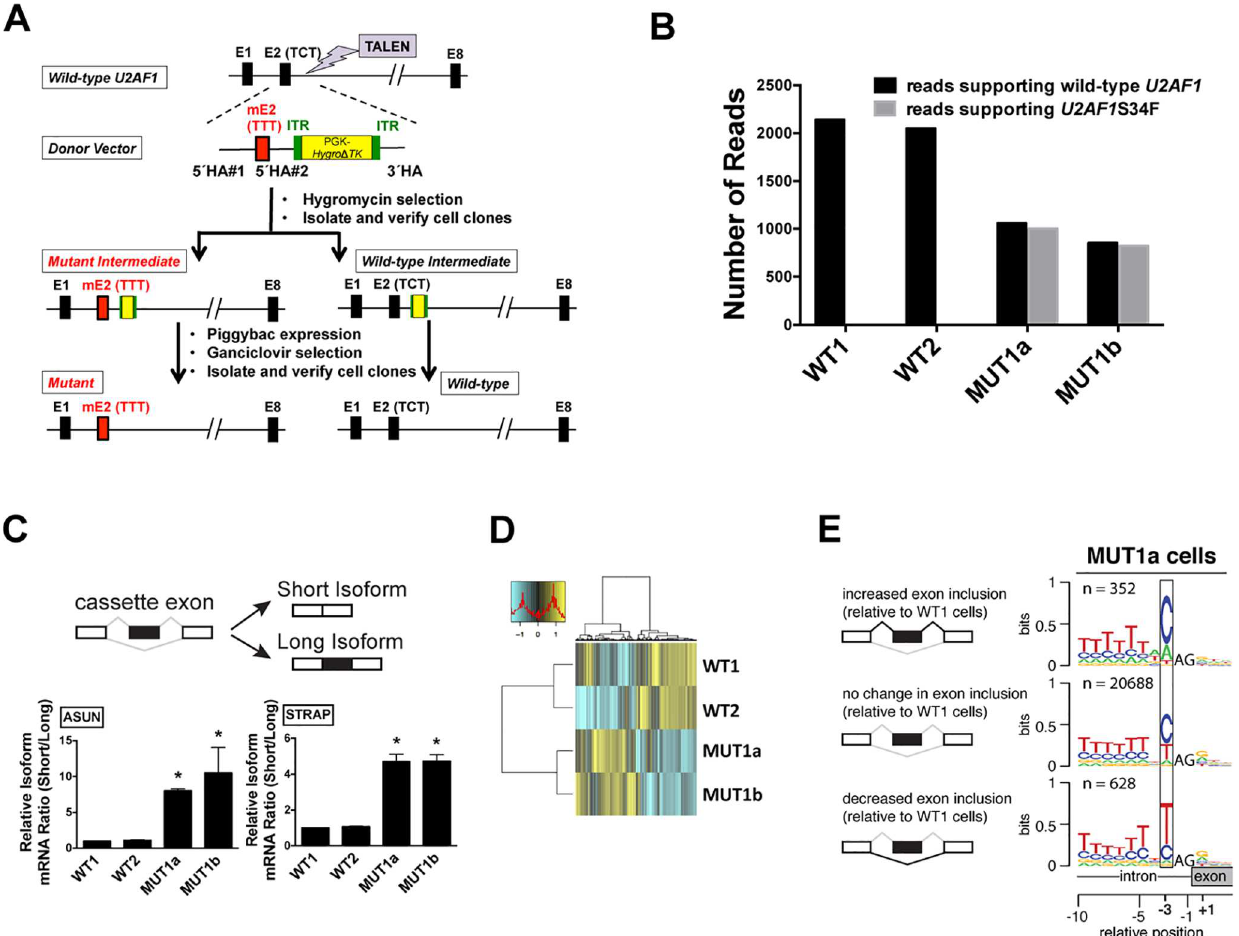
Fig 2. Creation of isogenic lung cell lines that recapitulate features of S34F-associated splicing. (A) . Strategy to create a TCT to TTT point mutation (S34F) at the endogenous U2AF1 locus in HBEC3kt cells. TALEN, transcription activator-like effector nuclease; E, exon; mE, mutant (S34F) exon; ITR, inverted terminal repeat; HA, homologyarm. See Results and Supplemental Materials and Methods for details. (B) . MUT1a and MUT1b cells contain similar levels of mutant and wild-type U2AF1 mRNA. The number of reads supportingmutant or wild-type U2AF1 was obtainedfrom RNA-seq, using poly(A)-selected RNA from the four cell lines. (C). The S34F-associated cassette exons in ASUN and STRAP mRNAs show decreased inclusionin MUT cell lines. (Top) Scheme of alternative splicing with a cassette exon (black box) to generate short and long isoforms in which the cassette exon is excludedor included.(Bottom) Alternativesplicing of cassette exons in ASUN and STRAP mRNAs, measured by RT-qPCR using isoform-specific primers. The short/long isoform ratio in WT1 cells was arbitrarily set to 1 for comparison. Asterisks represent statistical significant changes as compared to that in WT1 cells. Error bars represent s.e.m. (standard error of the mean) (n = 4). (D) . Heat map depictingthe inclusionlevels of all cassette exons that showed at least a 10% change in use among the cell lines. The dendrogramwas constructed from an unsupervised cluster analysis. (E). Sequence logos from 3 0 splice sites preceding cassette exons with altered inclusionin MUT1a cells display typical S34F consensus 3 0 splice sites. Logos were constructed as in Fig 1A based on the transcriptome of MUT1a cells in comparison with that of WT1 cells. Other comparisons of transcriptomes from MUT and WT cell lines yielded similar